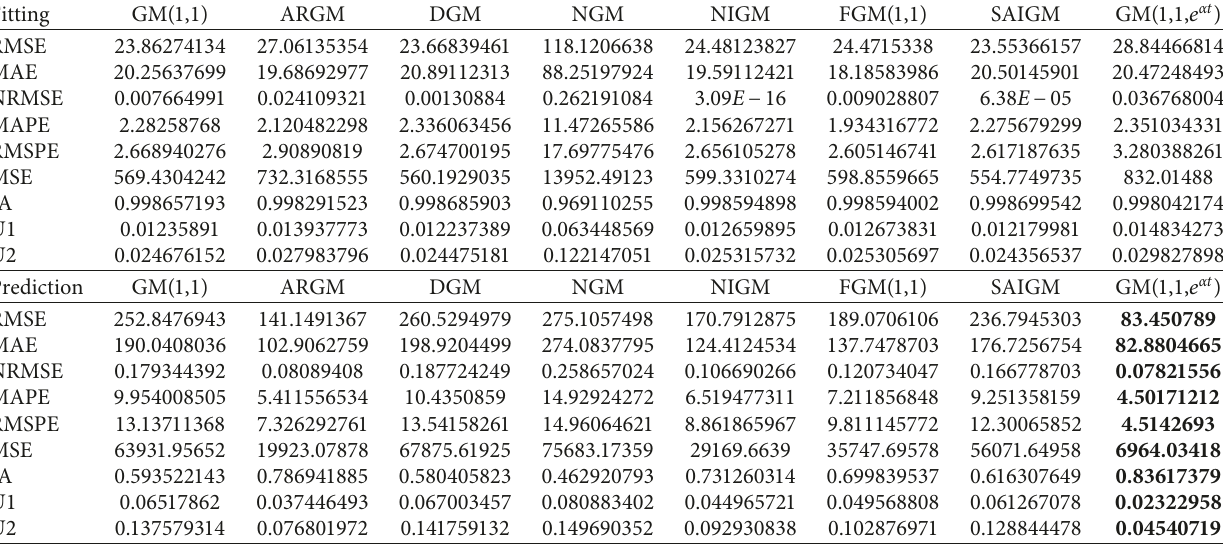
Table 6: Evaluation result of different grey models in Example